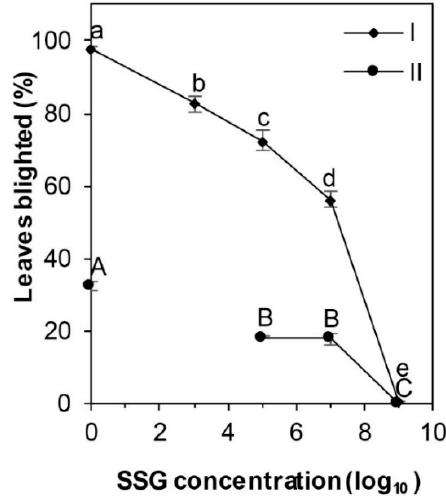
Figure 3. Leaf blight incidence on Buxus sempervirens ‘Justin Brouwers’ boxwood decreased with increasing SSG concentration from 0 to 10 9 cfu/mL applied one day prior to inoculation with Calonectria pseudonaviculata at 5 × 10 4 and 2 × 10 4 conidia/mL in the initial (I) and repeated experiments (II), respectively. Boxwood blight was assessed 7 days after inoculation. Data points represent mean leaves blighted (%) of three replicate plants and are presented with a standard error bar. Means marked with the same small case letter did not differ in the first run and those with the same uppercase letter did not differ in the repeated run according to the LSD test at p = 0.05.